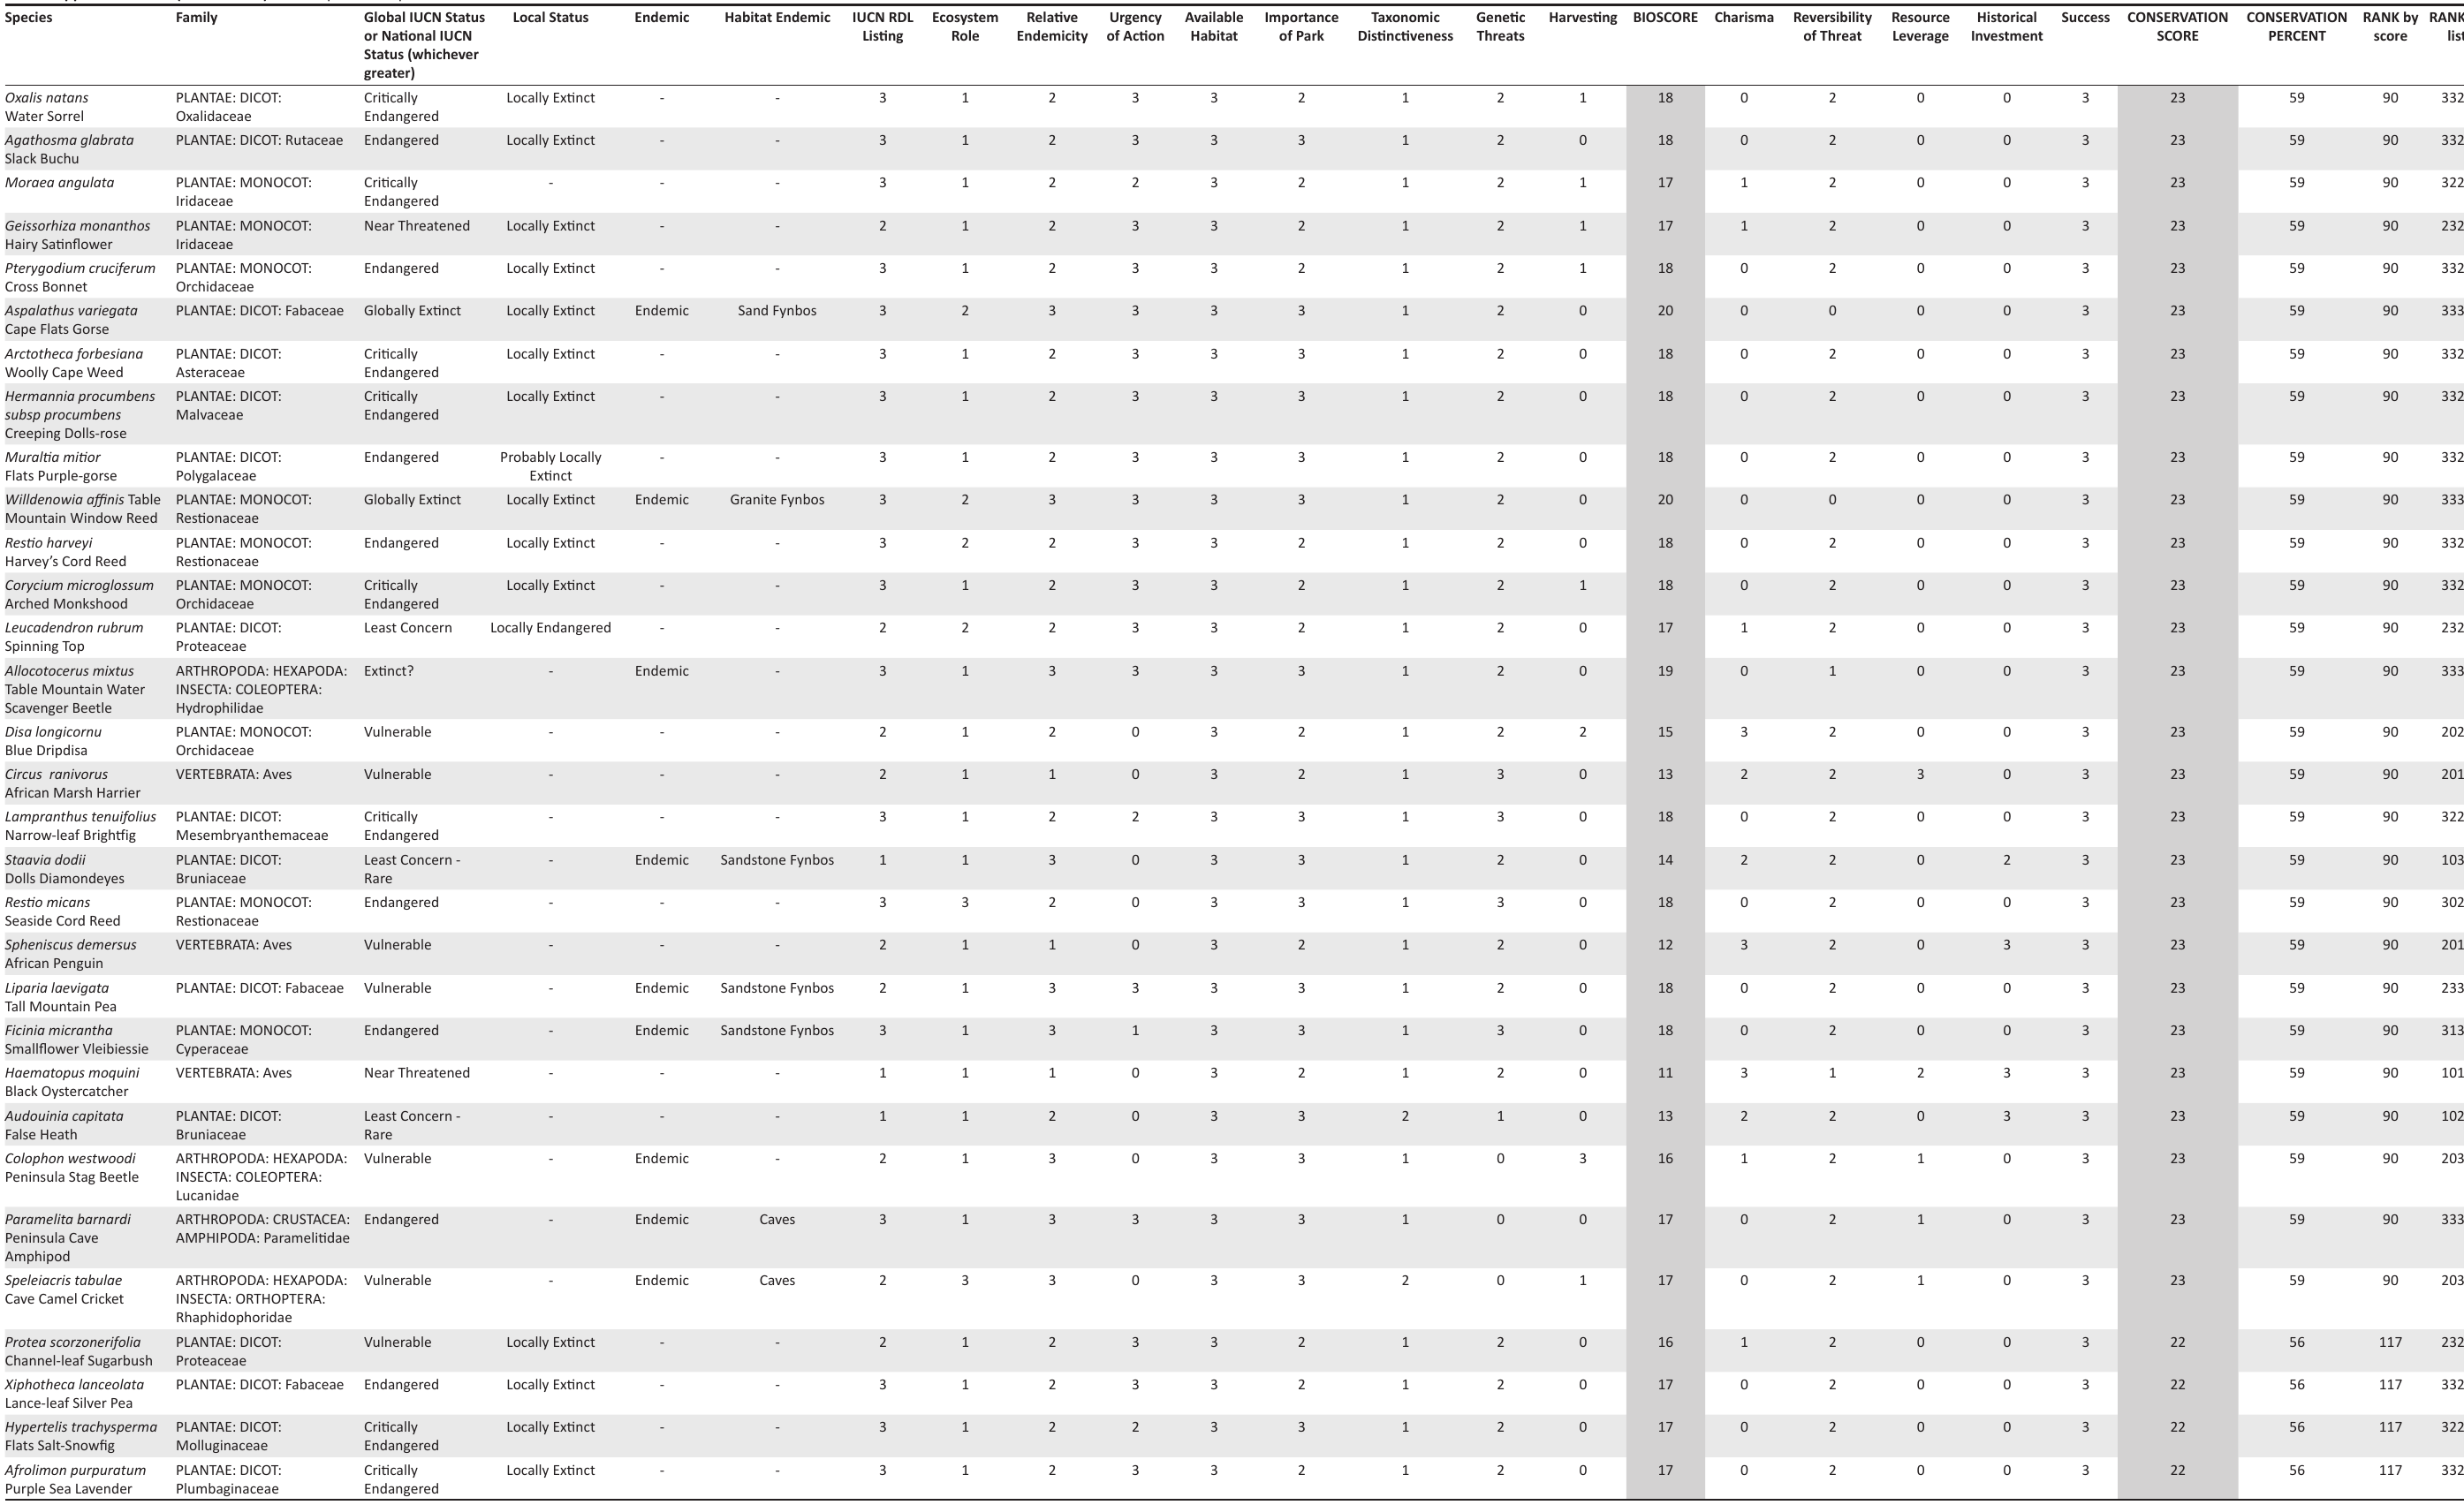
Online Appendix Table 1 (Continues...): List of species of Special Concern in the Table Mountain National Park and associated scores Species